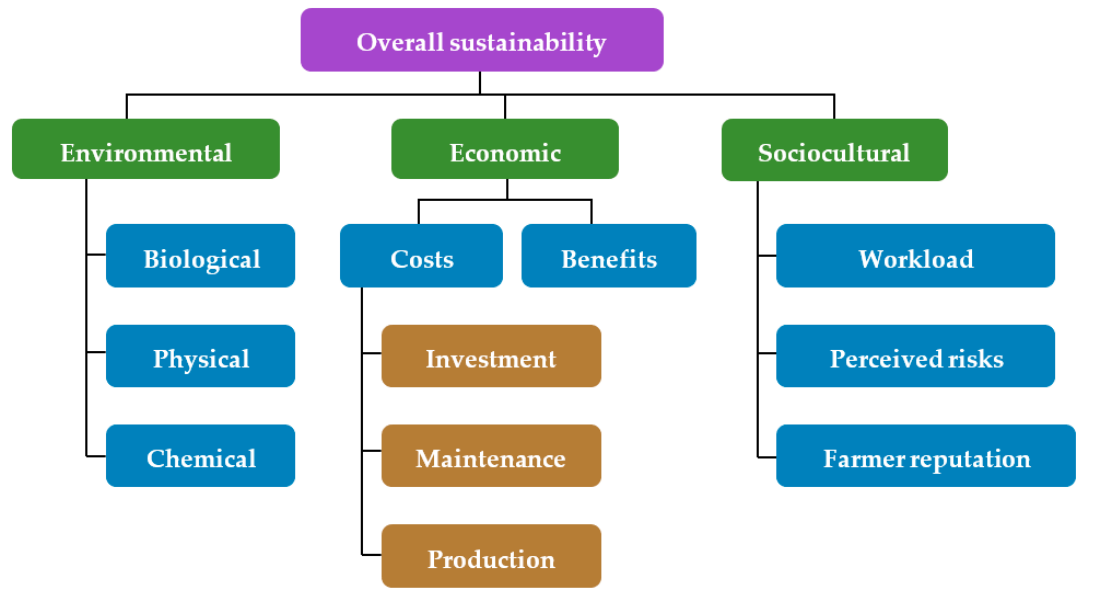
Figure 1. Structure of the aggregation of sustainability dimensions and assessment units. Table 1. Weighing factors attributed to variables as related to the four key topics (soil cultivation, soil fertilization, soil-improving crops, and soil